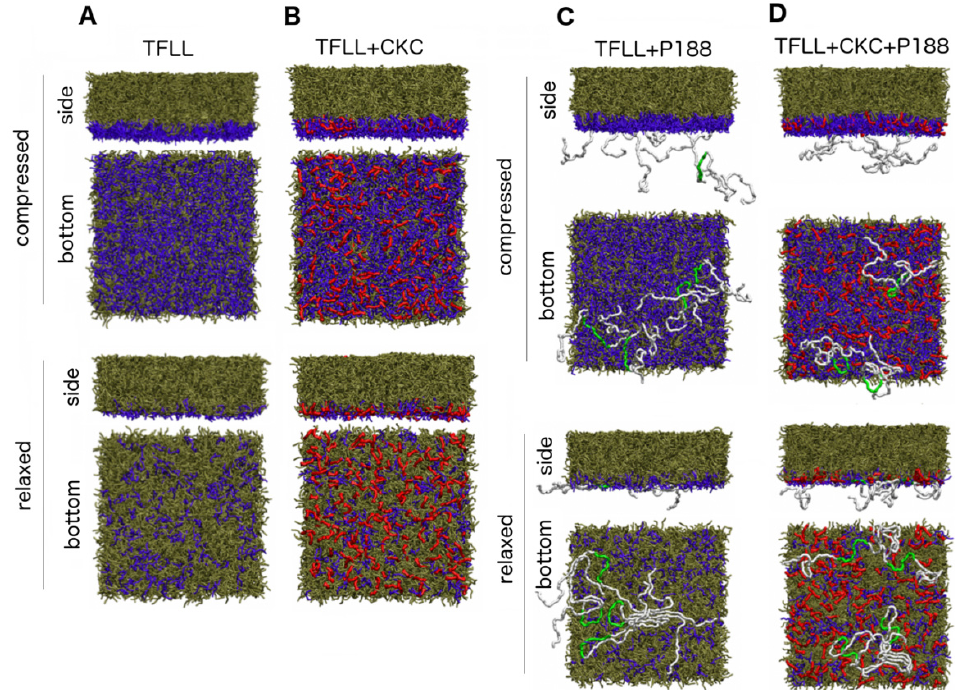
Figure 6. Simulation snapshots obtained in the course of simulation of the tear film lipid layer (TFLL) model ( A ), and the model in the presence of CKC ( B ), P188 ( C ), and the mixture of both CKC and P188 ( D ). In each case, snapshots for the simulation performed at area per polar lipid APPL = 91 Å 2 (designated as compressed) and 354 Å 2 (designated as relaxed) are presented. Side (upper panel) and bottom (lower panel) views of the lipid films are depicted for each system, the bottom views are taken from the direction of the water phase. Nonpolar lipids are shown in tan, polar lipids are shown in blue, CKC are shown in red, P188 hydrophobic cores are shown in green, and P188 hydrophilic tails are shown in white. Water molecules are omitted for clarity. Visualization was performed using VMD 1.9 software [32].